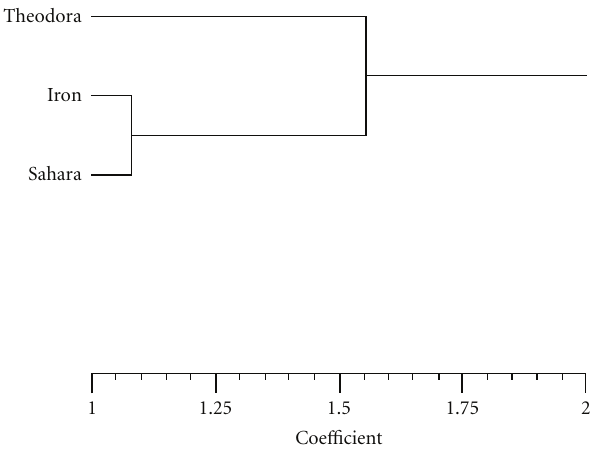
Figure 1: Dendrogram produced by cluster analysis based on DIST (average taxonomic distance) matrix for hybrids.